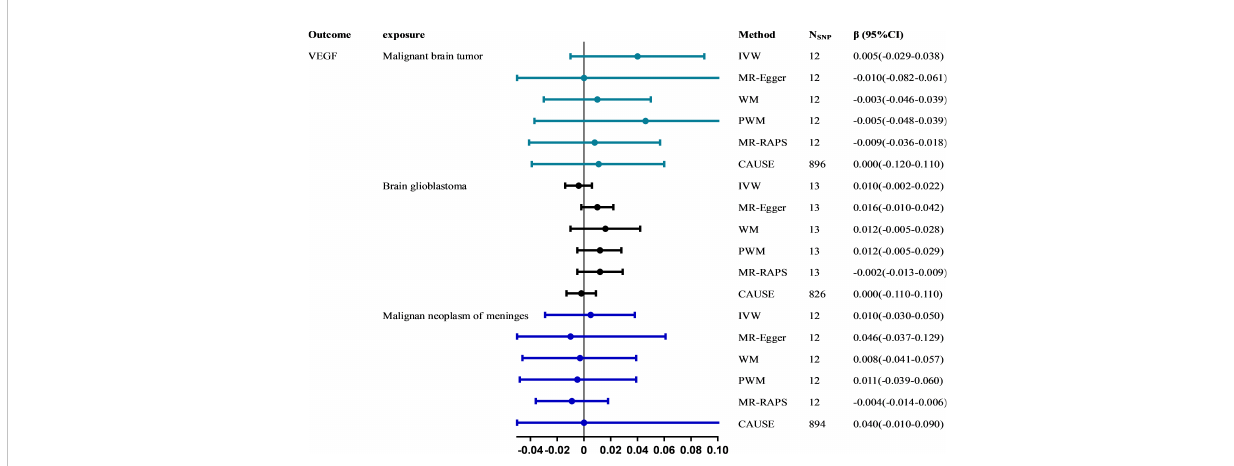
FIGURE 3 The causal effect of malignant brain tumors on VEGF estimated using six MR methods. The causal effect from malignant brain tumors to VEGF was expressed as b . Error bars represent the 95% CIs of the estimates. CAUSE recruited independent instrumental SNPs with GWAS p values < 1×10 -3 . SNP: single-nucleotide polymorphism; VEGF: vascular endothelial growth factor; IVW: inverse-variance weighted; WM: weighted median; PWM: penalty weighted median; MR.RAPS: robust adjusted pro fi le score; CAUSE: causal analysis using summary effect estimates; CIs: con fi dence intervals; MR: Mendelian